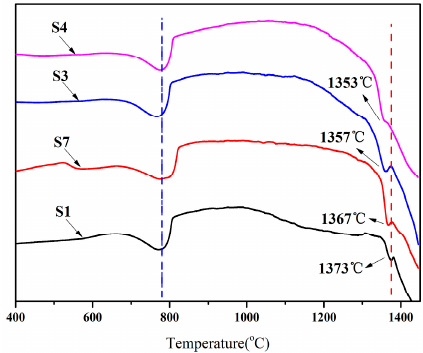
Figure 6. DSC curves for raw meals during heating process.